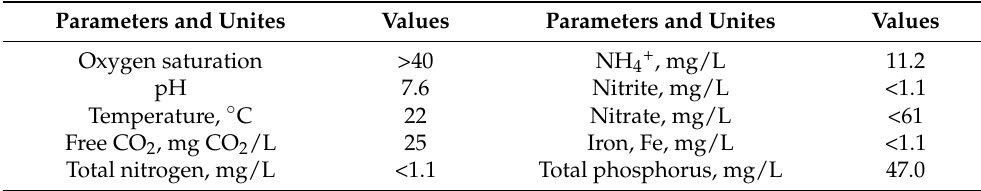
Table 6. Physical and chemical parameters of the wastewater from an open recirculation African catfish farming